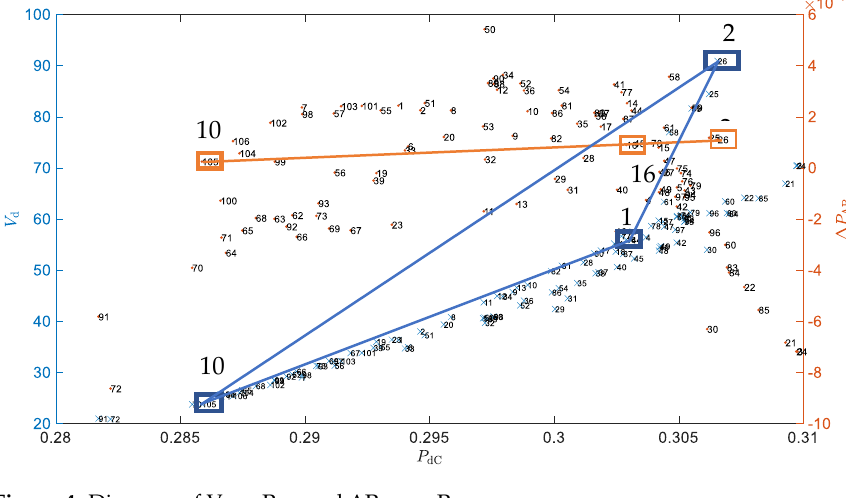
Figure 4. Diagram of V d − P dC and ∆ P AB − P dC .